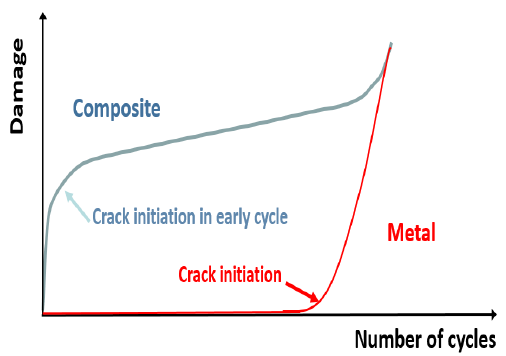
Figure 5. Stiffness change of a composite according to the number of cycles [2].